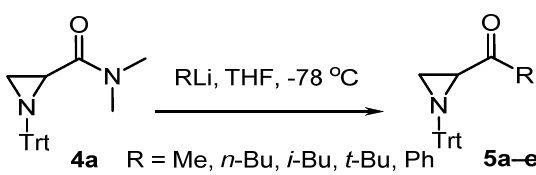
Table 2. Reaction conditions and yields of ketones 5a–e